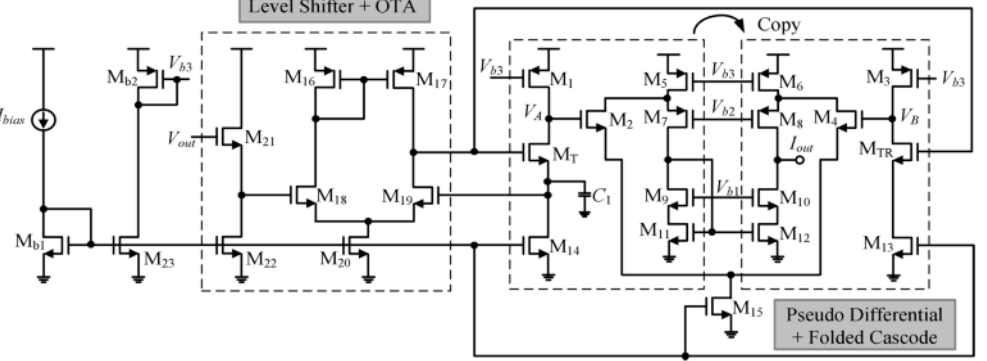
Figure 8. The basic structure of a conventional ALDO [40].